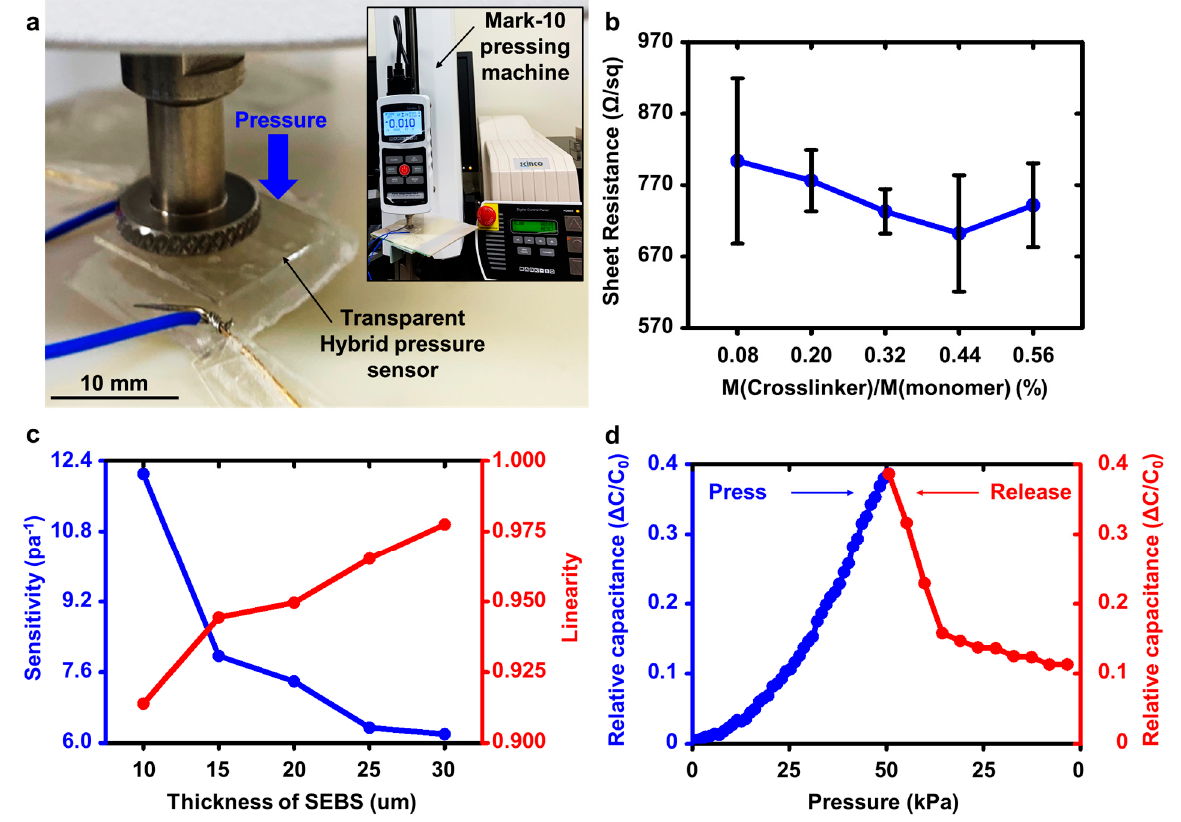
Figure 3. ( a ) Image of pressure sensing operation using a pressing machine (Mark-10). ( b ) Plot of sheet resistance of five tough conducting hydrogels as a function of with different crosslinking ratios. ( c ) Sensitivity (blue) and the corresponding linearity (red) of the pressure sensor versus thickness of SEBS. Variations in initial capacitance and sensitivity with respect to the thickness of SEBS for determining the range of use. ( d ) Pressure sensing profile of the pressure sensor when pressed and released.